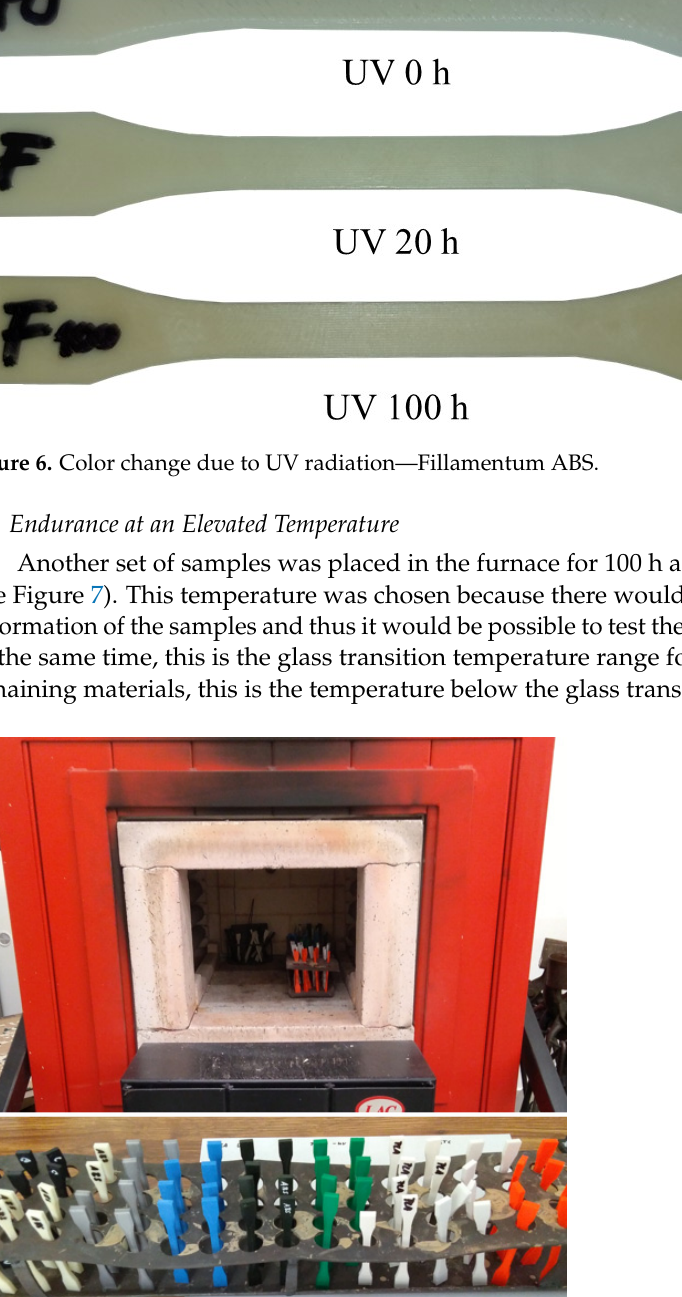
Figure 7. Set of test samples for placing in the furnace.